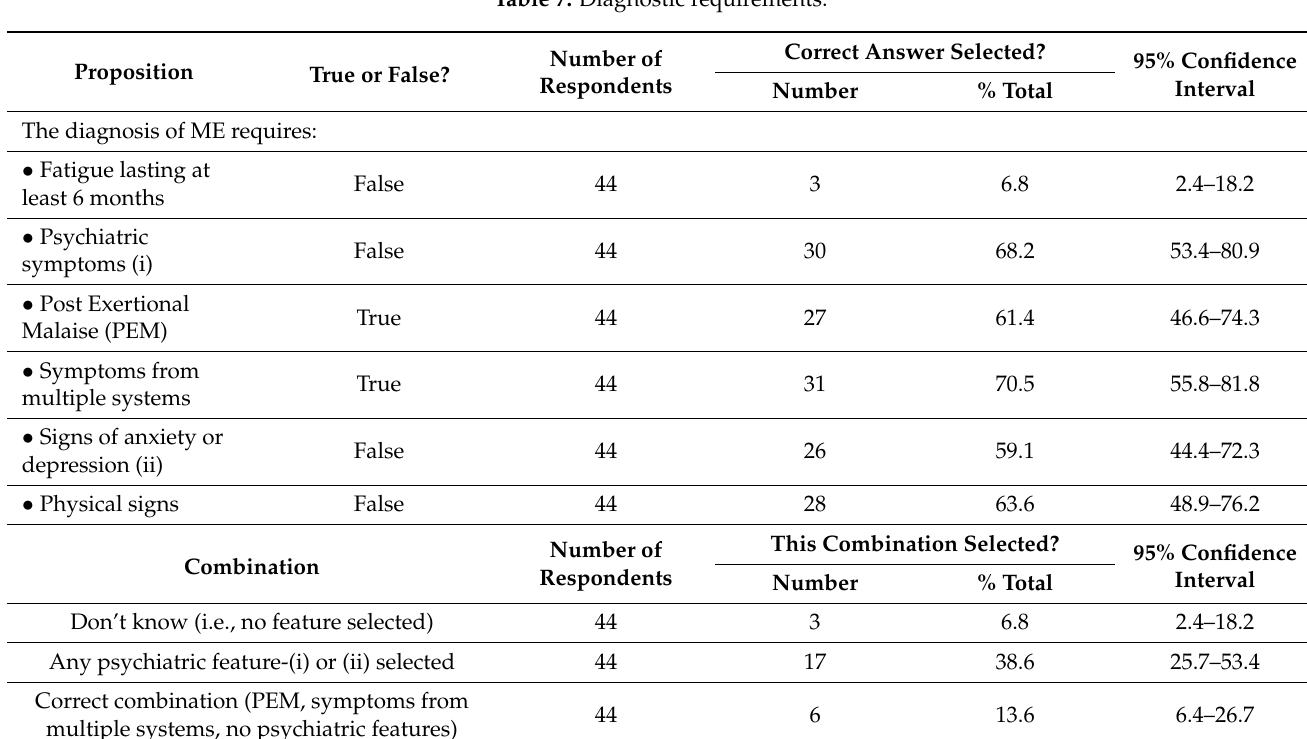
Table 7. Diagnostic